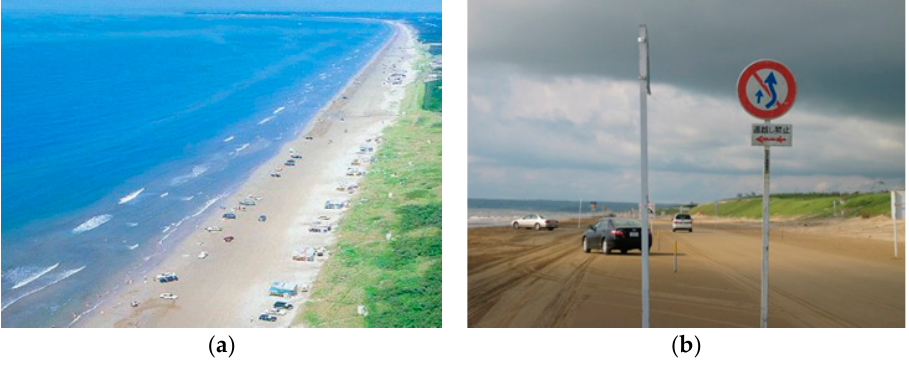
Figure 2. Nagisa Driveway on the Chirihama Coast.